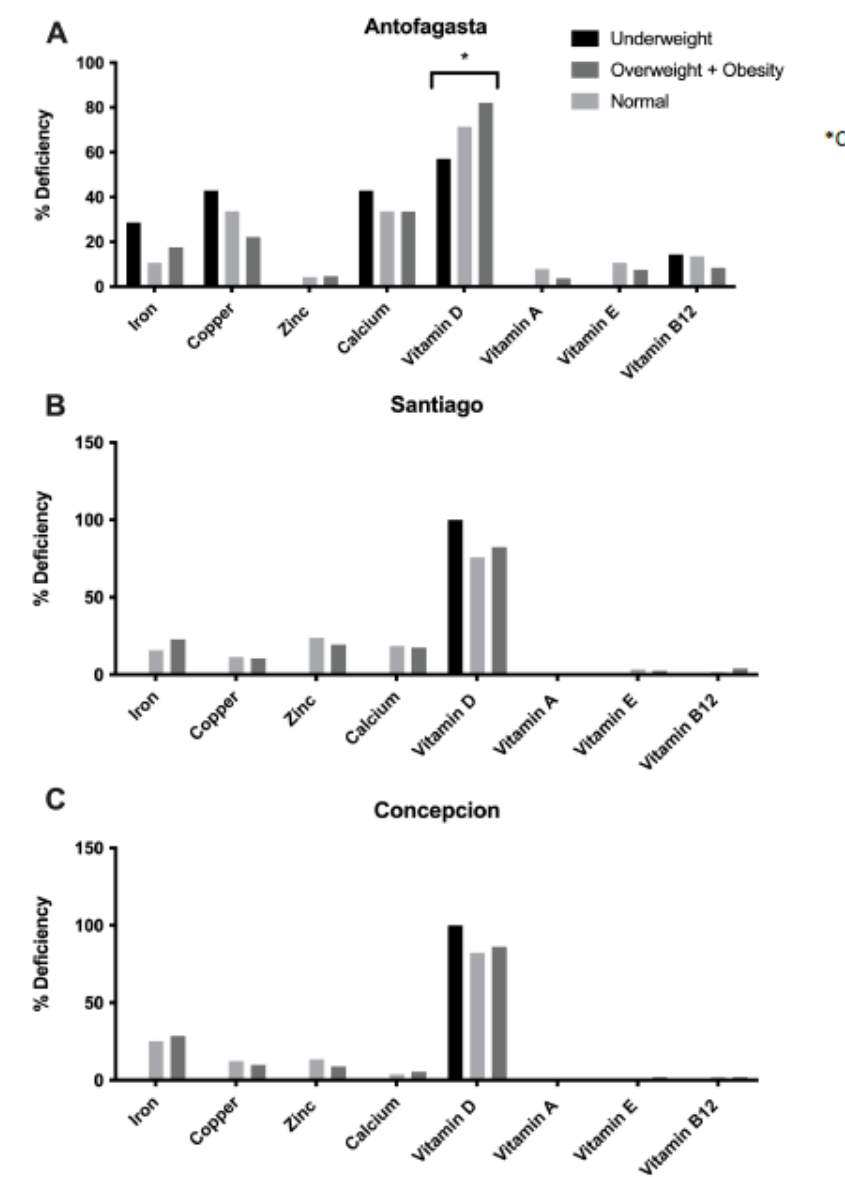
Figure 2. Plasma micronutrient deficiency according to nutritional status in ( A ) Antofagasta, ( B ) Santiago, and ( C ) Concepcion. (* significant difference in nutritional status).